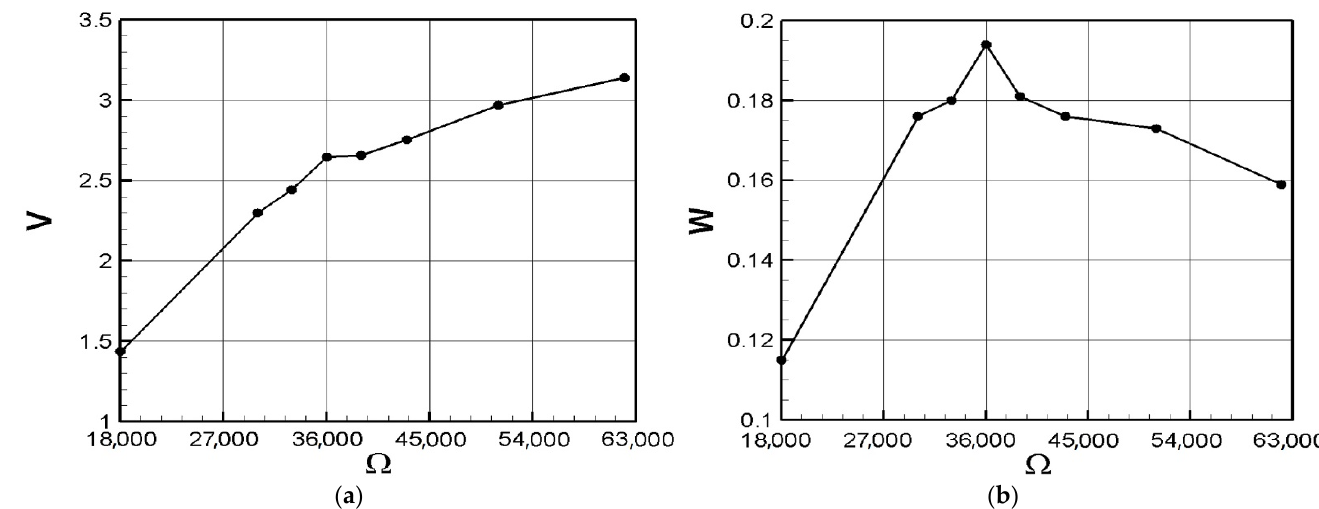
Figure 15. Diagram of ohm-volt and ohm-power, ( a ) ohm-volt diagram, and ( b ) ohm-power diagram.